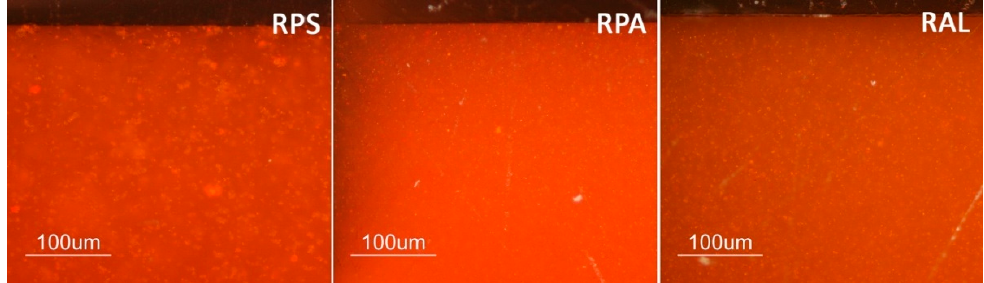
Figure 1. Optical microscopy (OM) images of cross-sections of the different red PMMA samples before artificial aging. Images acquired under reflected light and cross-polarizing filters at 200× original magnification.